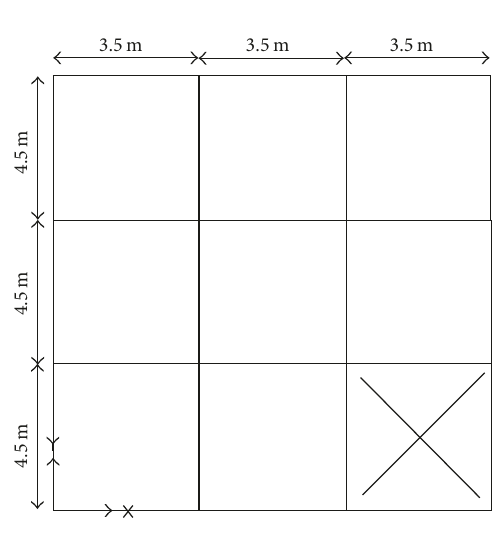
Figure 1: Typical plan view.